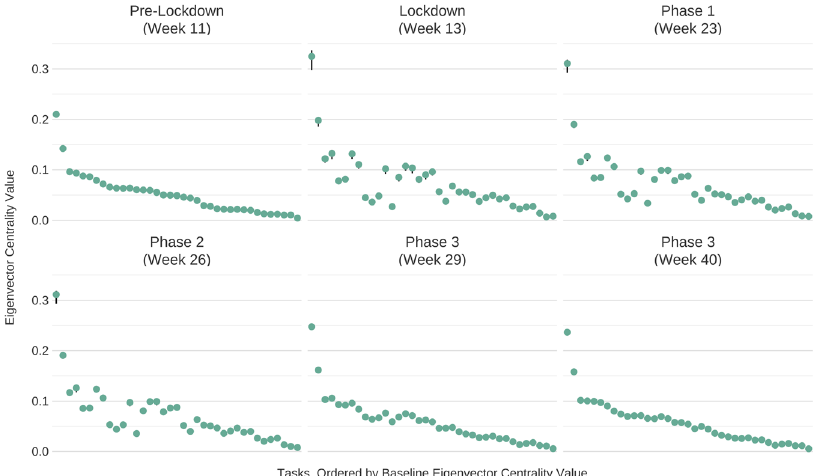
Fig. 7 Distribution of EC values for nodes in the Tasks level; in descending order of baseline values, with error bars indicating sensitivity – see Methods section. Tasks in weeks 13, 23, 26, 29 and 40 are all plotted in the same fi xed location to demonstrate which Tasks fall or rise in EC value, throughout the modelled